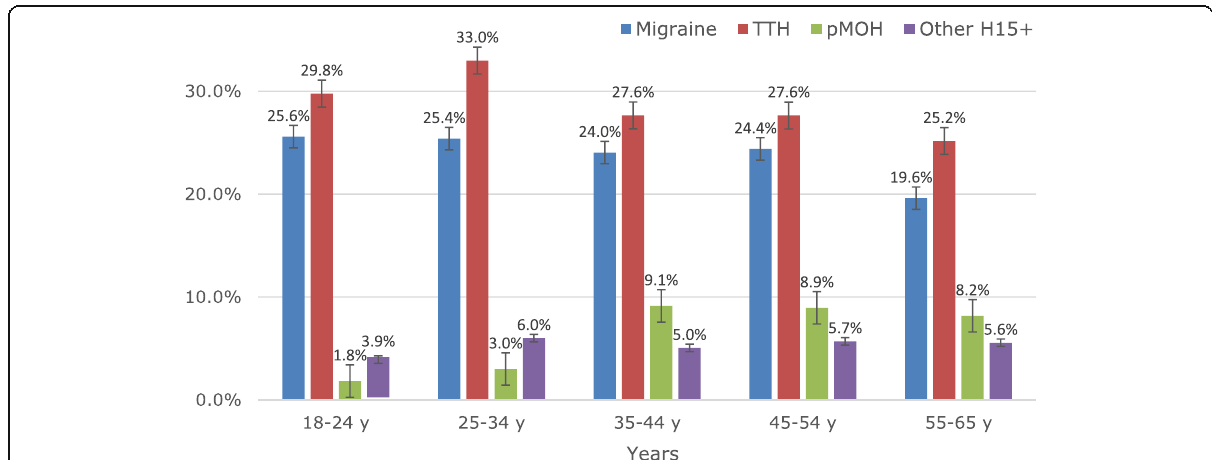
Fig. 2 Age related prevalence of each headache type (TTH: tension-type headache; pMOH: probable medication-overuse headache; Other H15+: other headache on ≥ 15